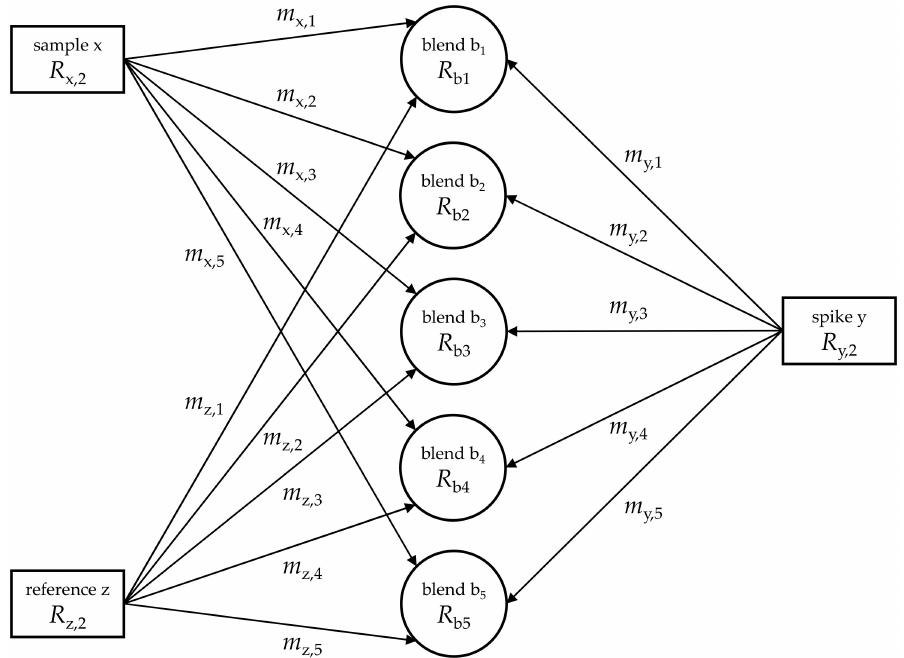
Figure 2. Relationship of the initial components (sample x, spike y, and reference z) and the respective blends (b i ), indicating (a) the abundances in which the components were blended and (b) the quantities, which have to be measured to be able to calculate analyte mass fraction w x in the